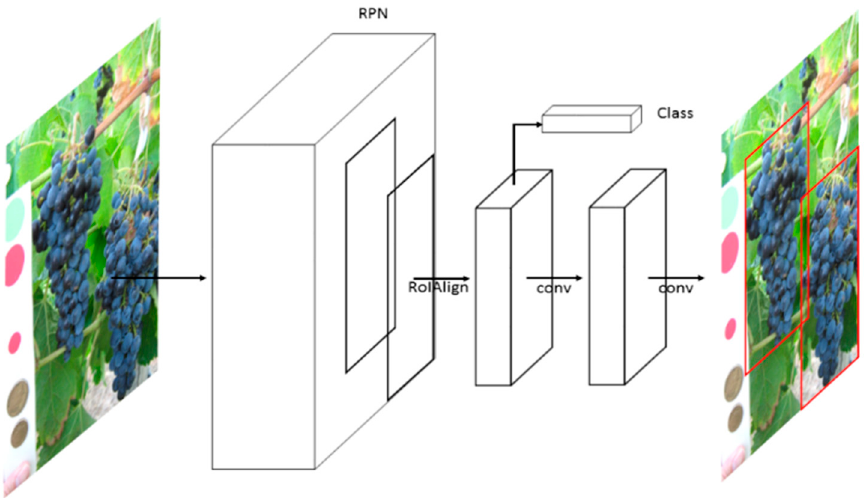
Figure 5. MaskR-CNN framework (He et al. [28]). In this two-stage procedure, the first stage, called Region Proposal Network (RPN), estimates the position of bounding boxes. The second stage performs a classification, a bounding box regression, and extracts a binary mask.